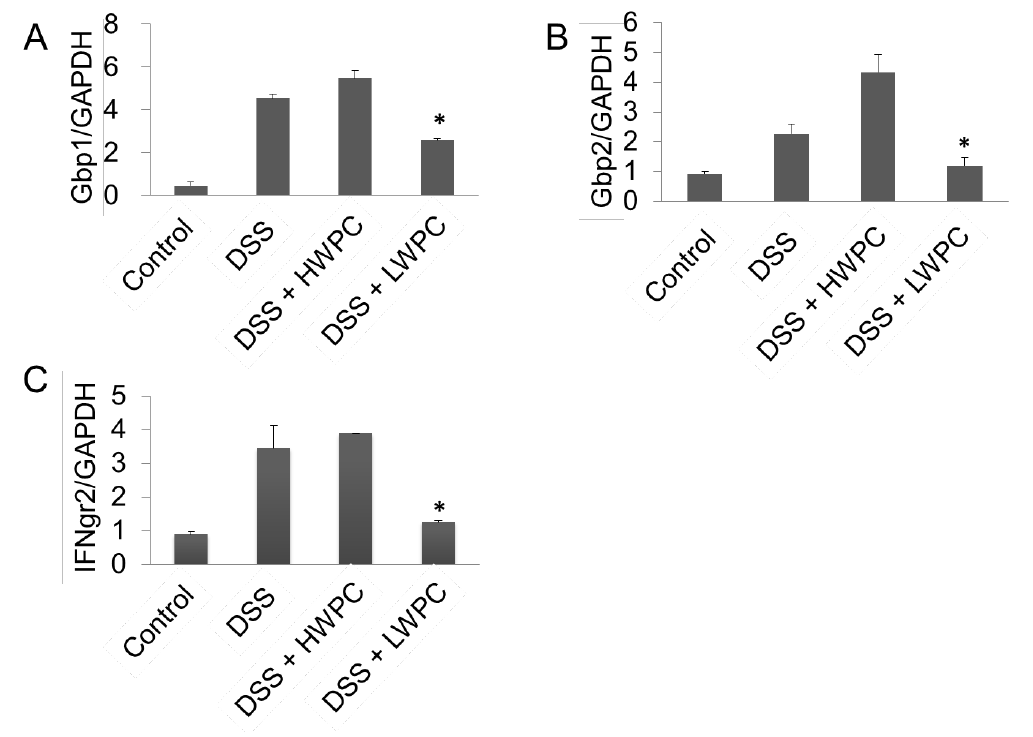
Figure 6. Gene expression analysis by real-time QPCR. The relative expression levels of Gbp1, Gbp2 and IFNgr2 are shown as ratios compared with GAPDH. * Statistically significant difference from the DSS group ( p <